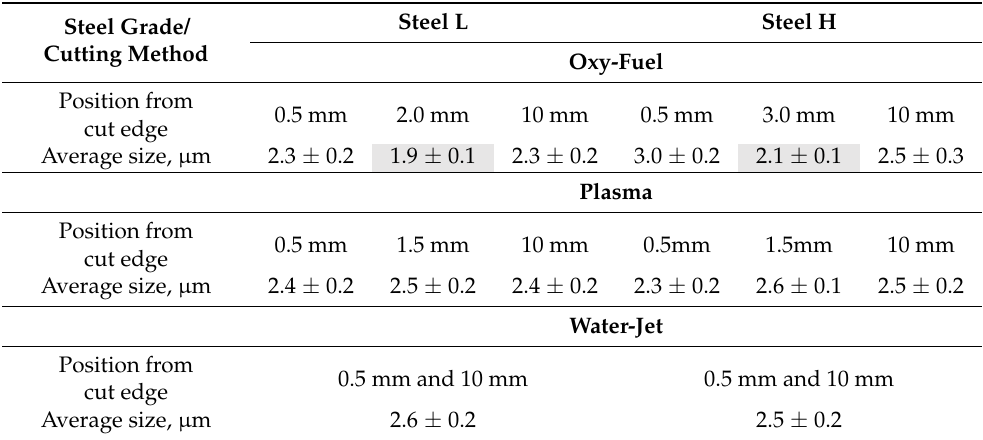
Table 2. Average grain size in the studied steels.